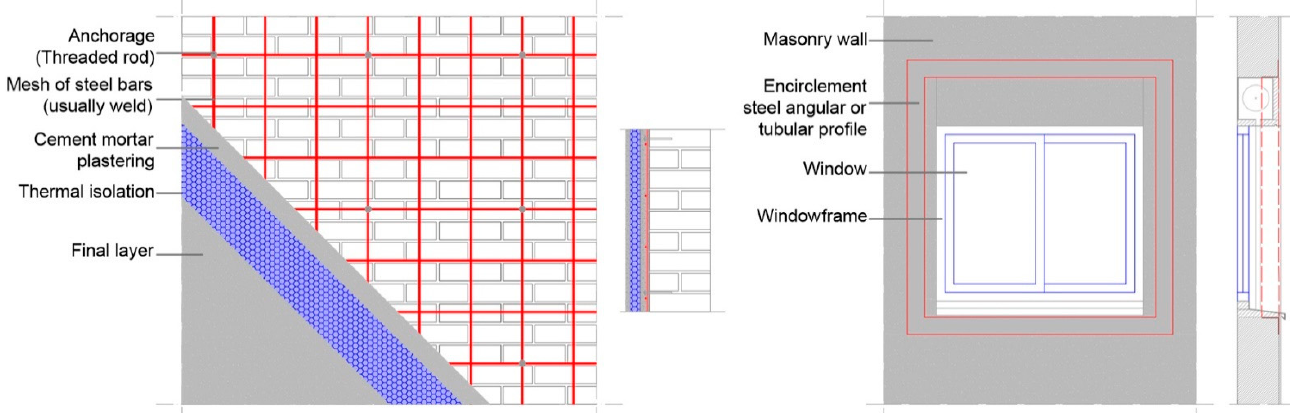
Figure 10. Conceptual details of the retrofitting packages: wall strengthening and addition of thermal insulation and addition of encirclements and window replacement/enhancement.